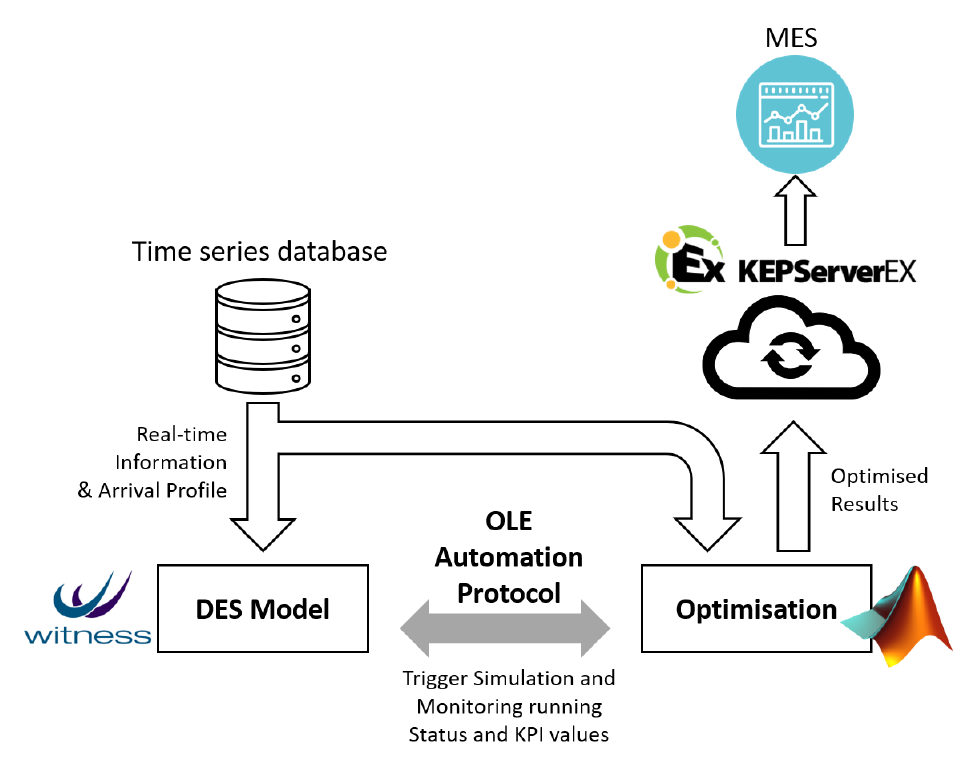
Figure 2. The real-time data communication